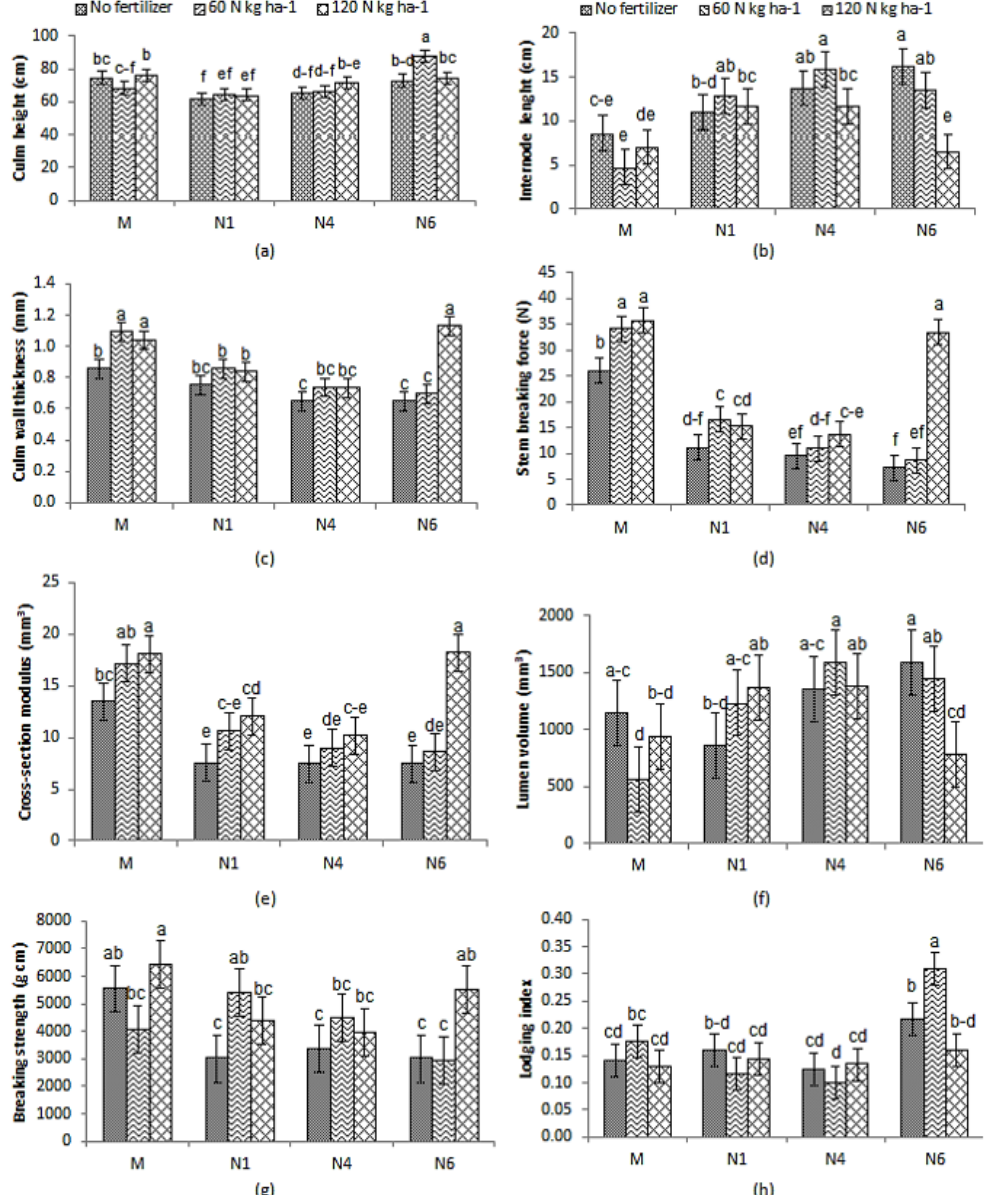
Figure 1: Interaction of nitrogen fertilizer rates and cultivar on (a) culm height (b) internode length, (c) culm wall thickness, (d) stem breaking force, (e) cross-section modulus, (f) lumen volume (g) breaking strength and (h) lodging index, of the primary tiller of rice cultivars. M = Moroberekan; N1, 4, and 6 are respectively NERICAs 1, 4 and